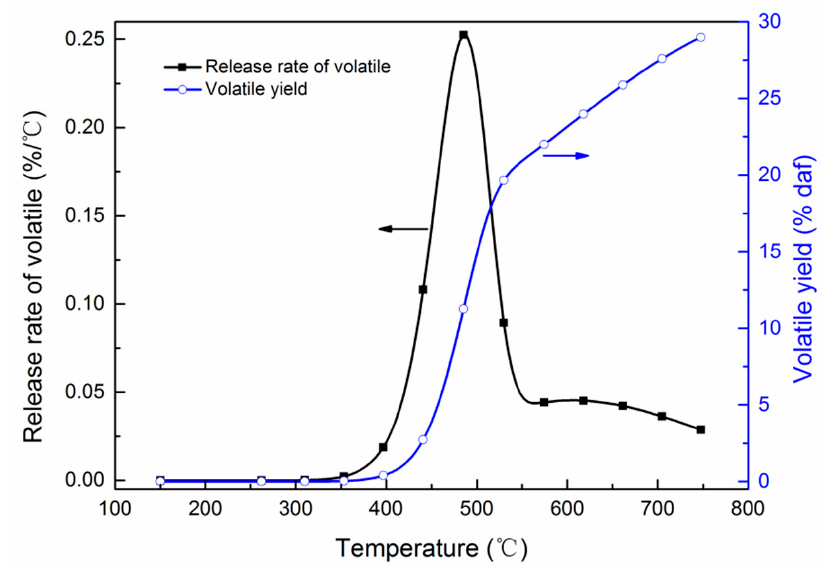
Figure 3. Volatile yield and its release rate from the coal particle as a function of temperature ( d = 20 mm).